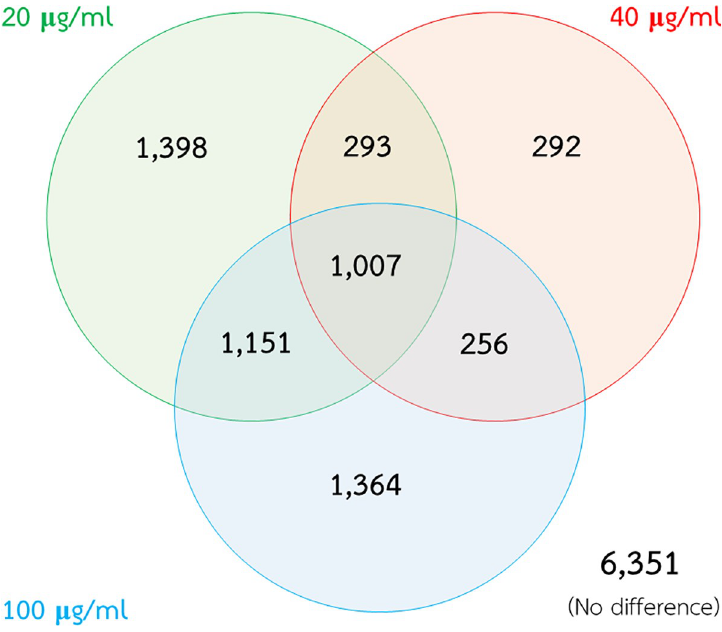
Fig 1. Alteration of S . mekongi metabolites after PZQ treatment. Green, red, and blue circles represent differential metabolites after low-, medium-, and high-dose PZQ treatment, respectively.